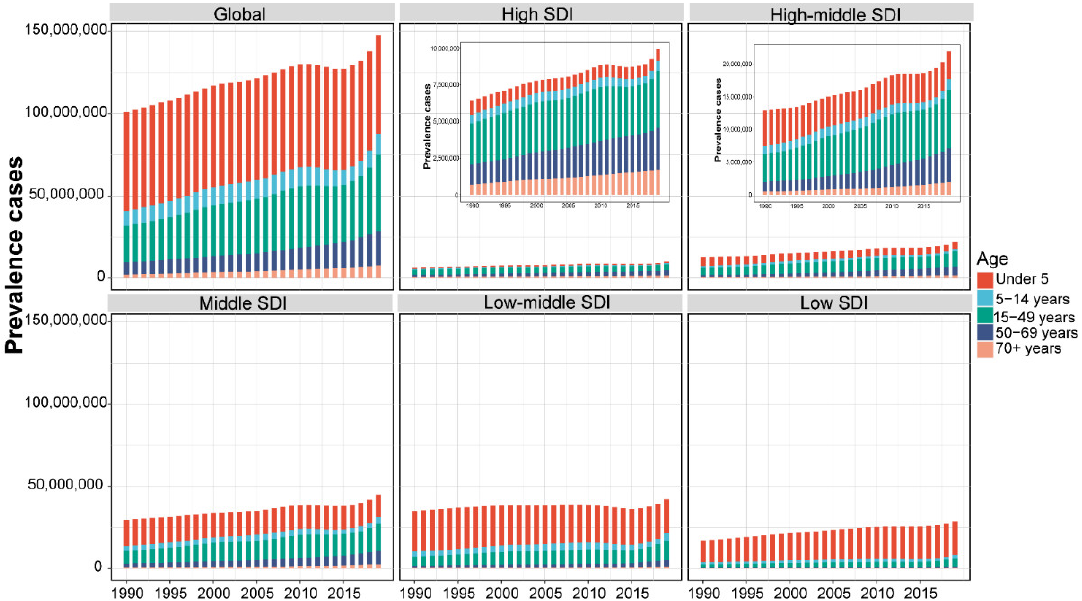
Figure 6. The proportion of the five age groups for protein–energy malnutrition prevalence cases between 1990 and 2019 globally, and in High, High-middle, Middle, Low-middle, and Low SDI quintiles. The populations were divided into five age groups: under 5, 5–14 years, 15–49 years, 50– 69 years, and 70+ years. SDI values can be used to judge the degree of economic development of a country or region.